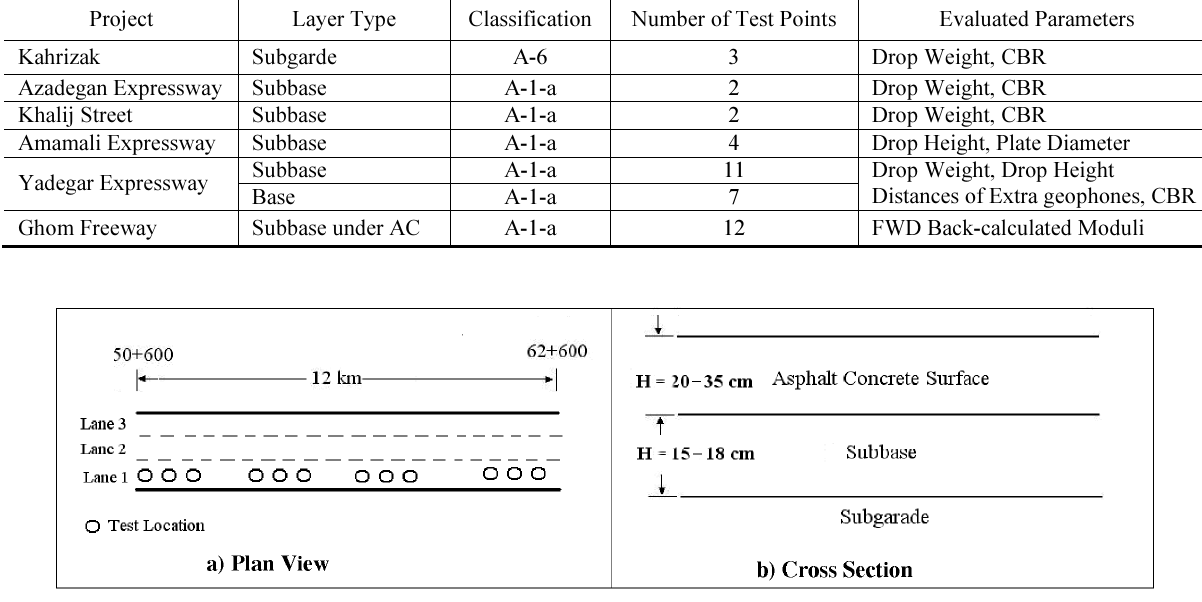
Fig. 2. Test locations at FWD and PFWD